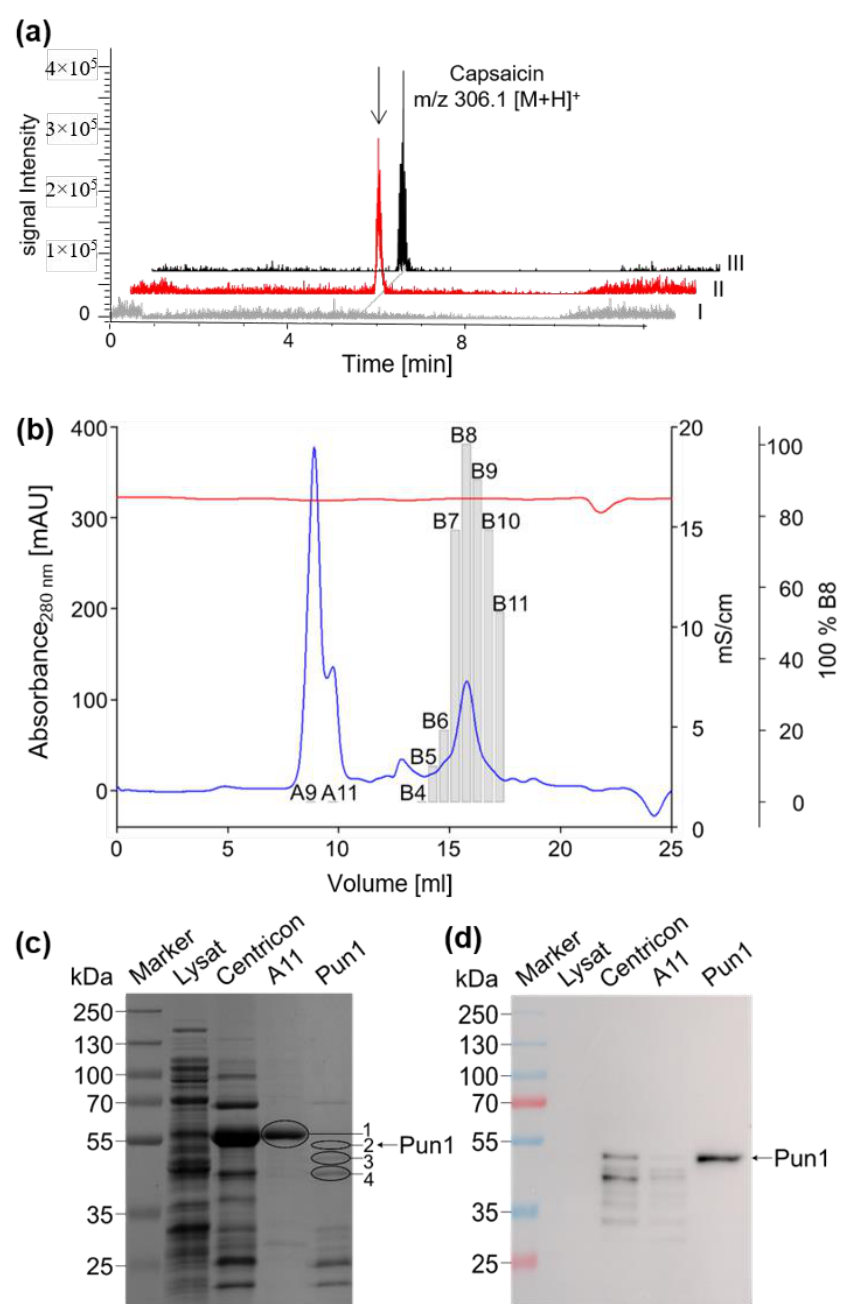
Figure 2. ( a ) Partial purification of recombinant capsaicin synthase. Capsaicin product formation (II) was detected in crude enzyme extracts. Retention time and mass signals were identical to a commercially available standard of capsaicin (III), m/z 306.1 [M + H] + . Concentrated capsaicin synthase was purified by size exclusion chromatography, ( b ) and the UV 280nm and activity signals are overlaid. Gray bars represent the relative enzyme activity of individual fractions as compared to fraction B8, which was set to 100%. ( c ) and ( d ) represent the SDS-PAGE protein profile and the corresponding Western blot of individual purification steps. The three dominant bands corresponding to the combined SEC fractions, B7-B10, shown in ( b ) at 52 kDa (2), 50 kDa (3), and 48 kDa (4), were cut out from the SDS-PAGE gel together with band (1), correlating to the strongest UV 280nm signal in ( b ) but without any activity. All were checked for the presence of capsaicin synthase by tryptic digest and subsequent peptide sequencing.